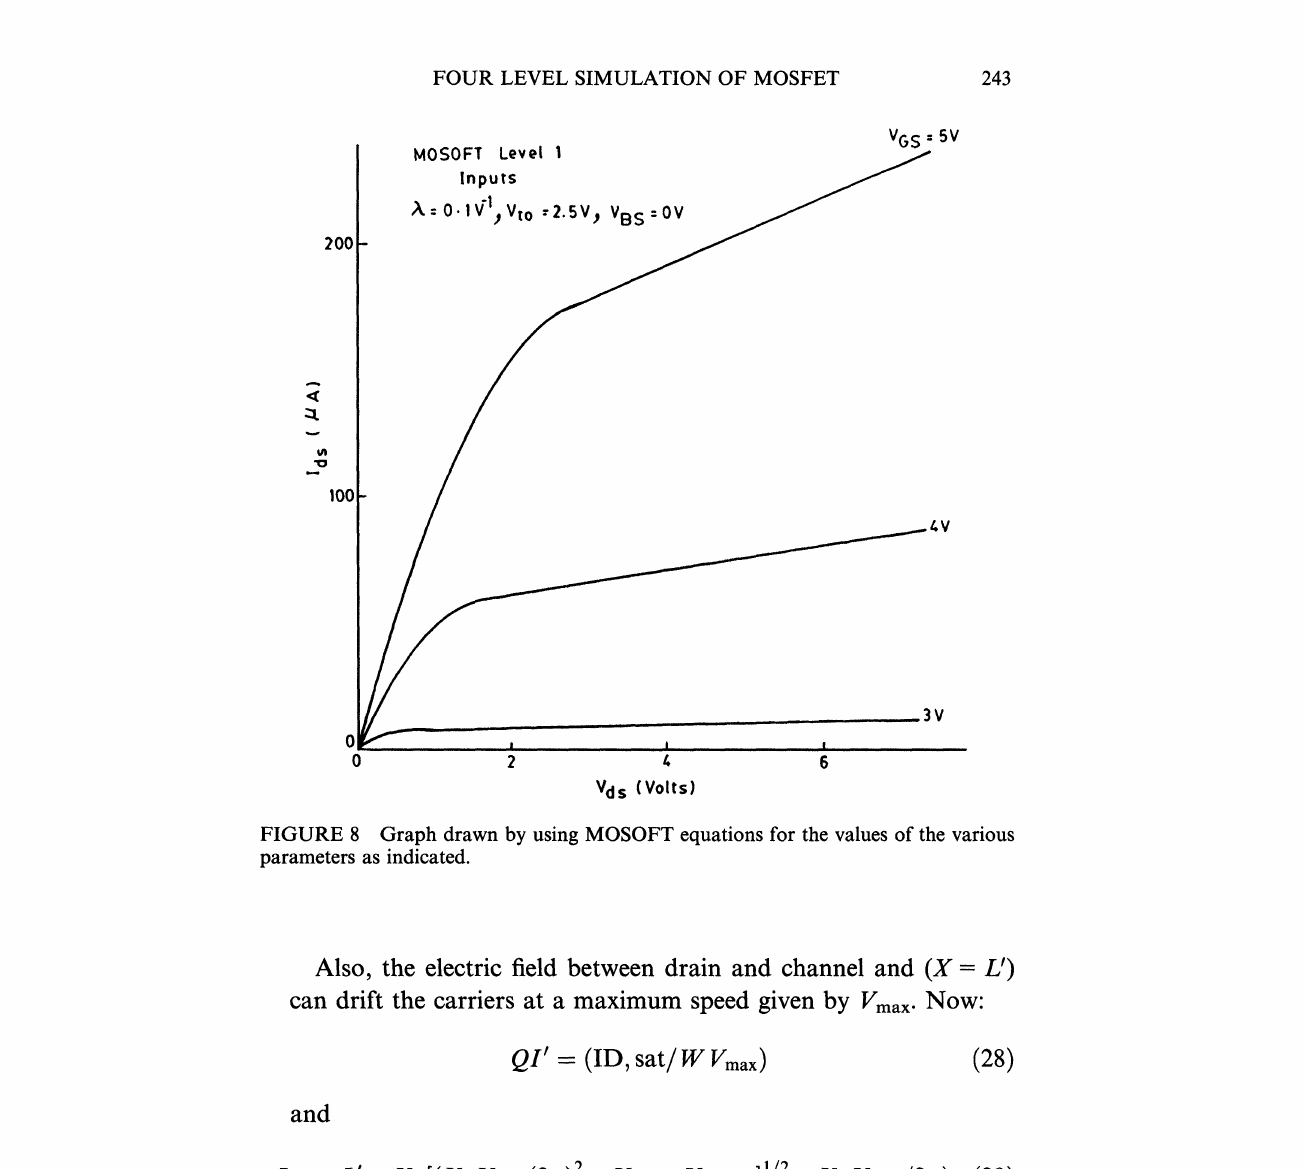
FIGURE 8 Graph drawn by using MOSOFT equations for the values of the various parameters as